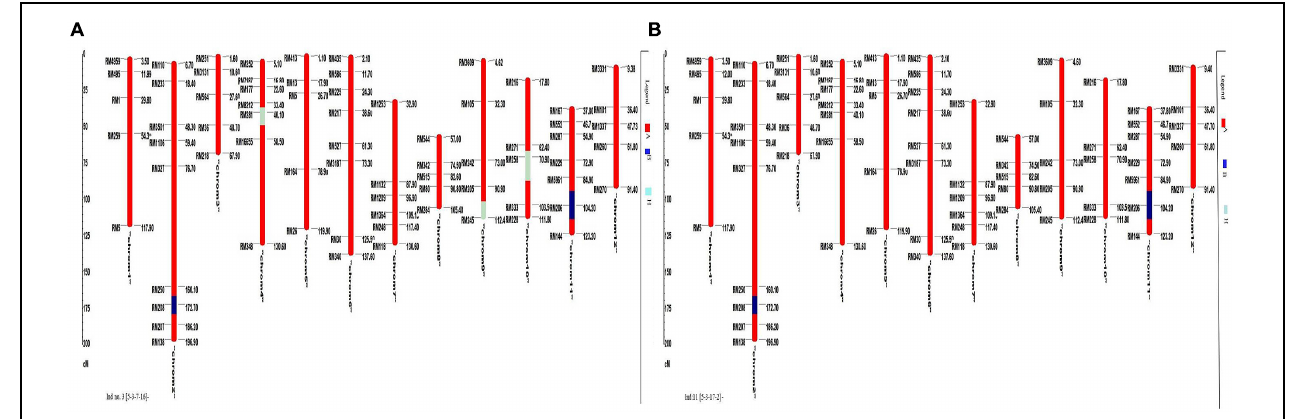
FIGURE 5 | Graphical genotyping of the improved lines with the lowest (A) and highest (B) recovery among the best 15 improved lines. The red color indicates homozygous regions for MR219, the blue color indicates homozygous regions for Pongsu Seribu 2 and the light green color indicates heterozygous